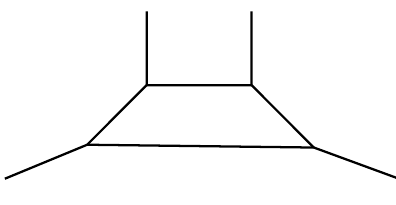
Figure 8 . A possible alternative brane realization of the 5d N = 1 pure SU(2)